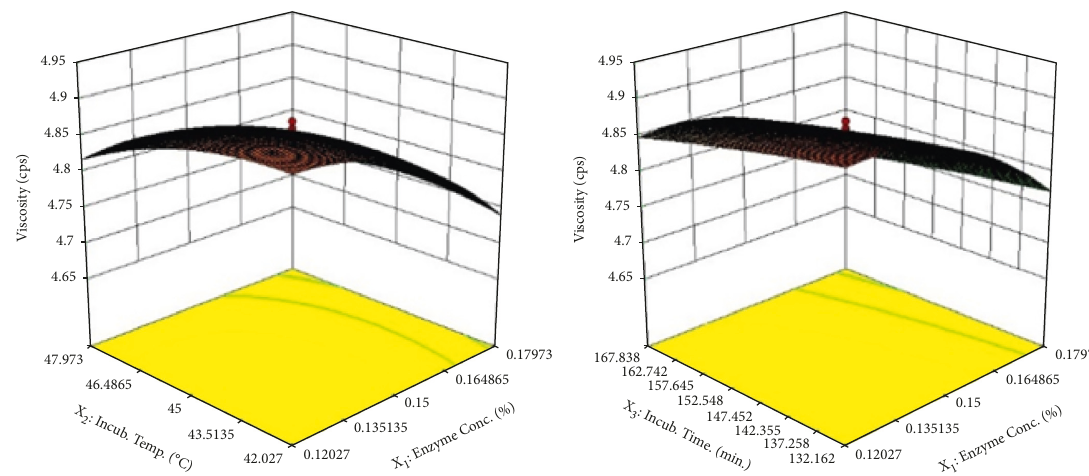
Figure 3: 3D graph plots displaying the interactive effect of factors on